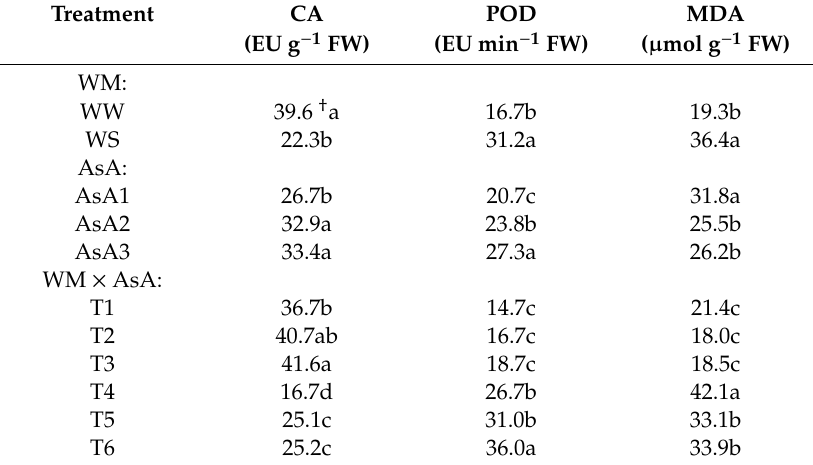
Table 2. The e ff ect of water management (WM) and ascorbic acid (AsA) on carbonic anhydrase activity (CA) peroxidase activity (POD), and malondialdehyde (MDA) of common bean plants. Treatment CA POD MDA (EU g − 1 FW) (EU min − 1 FW) ( µ mol g − 1 FW) WM: WW 39.6 †